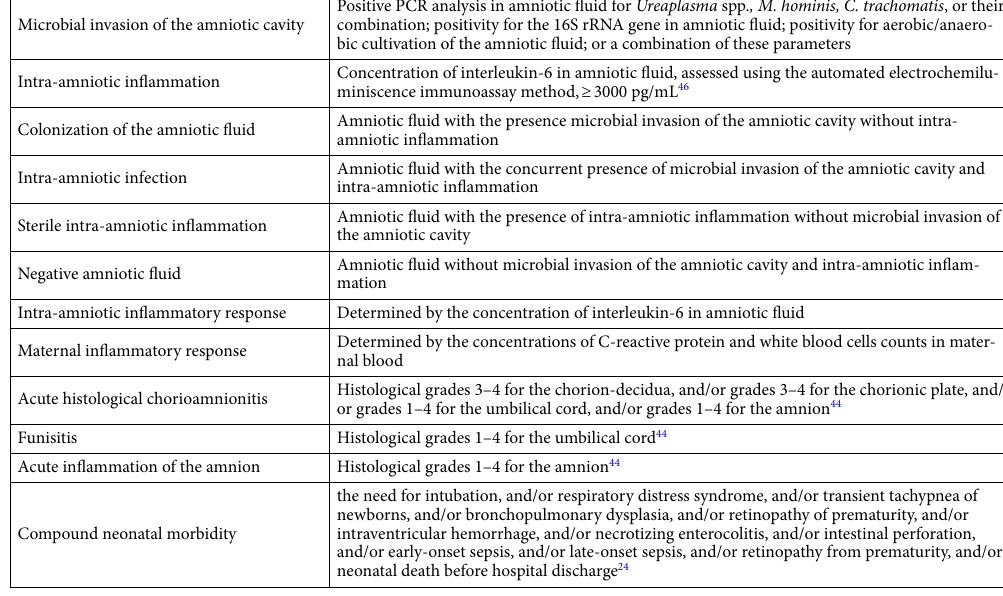
Table 1. The clinical